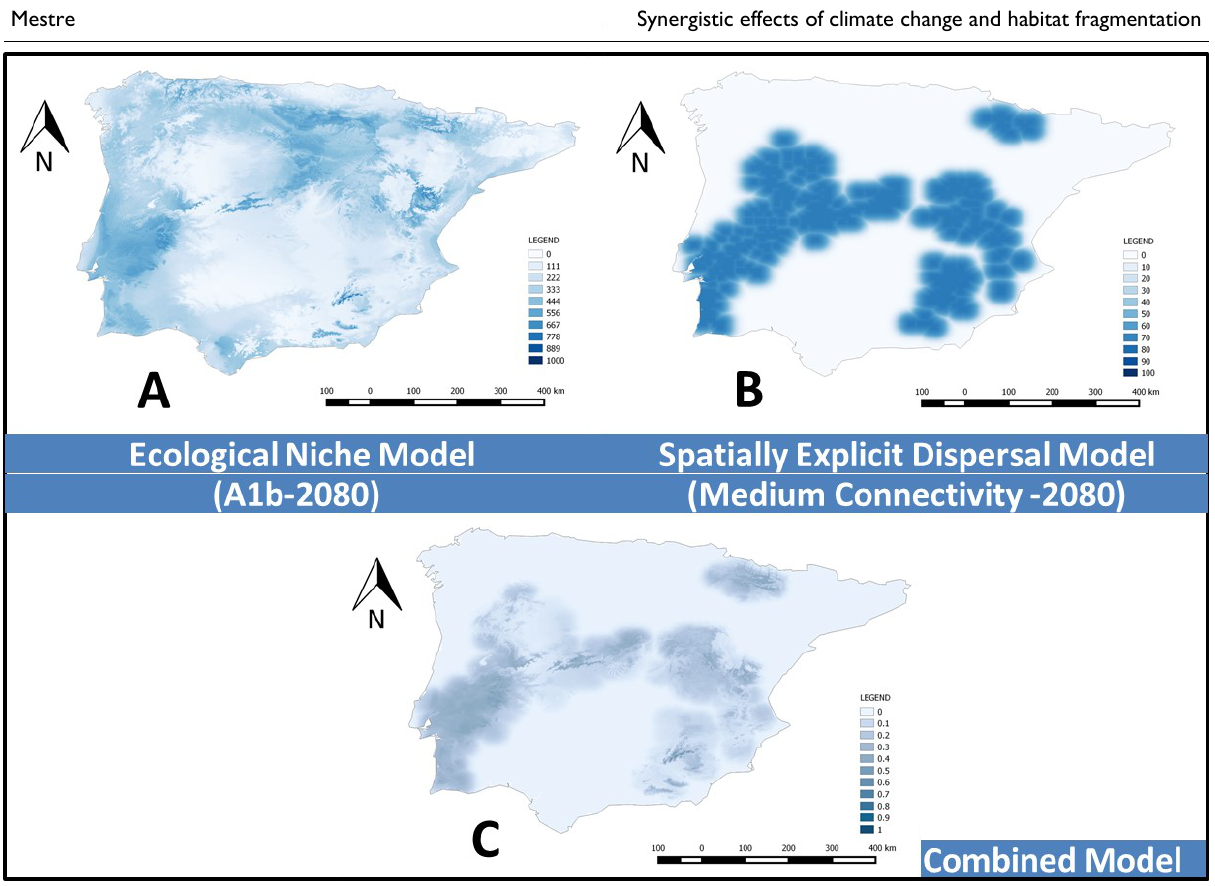
Figure 3. Example of the integration of Ecological Niche Models (ENMs) with Spatially Explicit Dispersal Models (SEDMs) to project the potential future distribution of the Cabrera vole. ( A ) ENM of the climate change scenario A1b in 2080, which considers ecological niche requirements only. ( B ) SEDM of medium connectivity in 2080, which incor- porates dispersal limitations and landscape characteristics. ( C ) Combined Model. Additional results in Mestre et al. (2017b) and Mestre